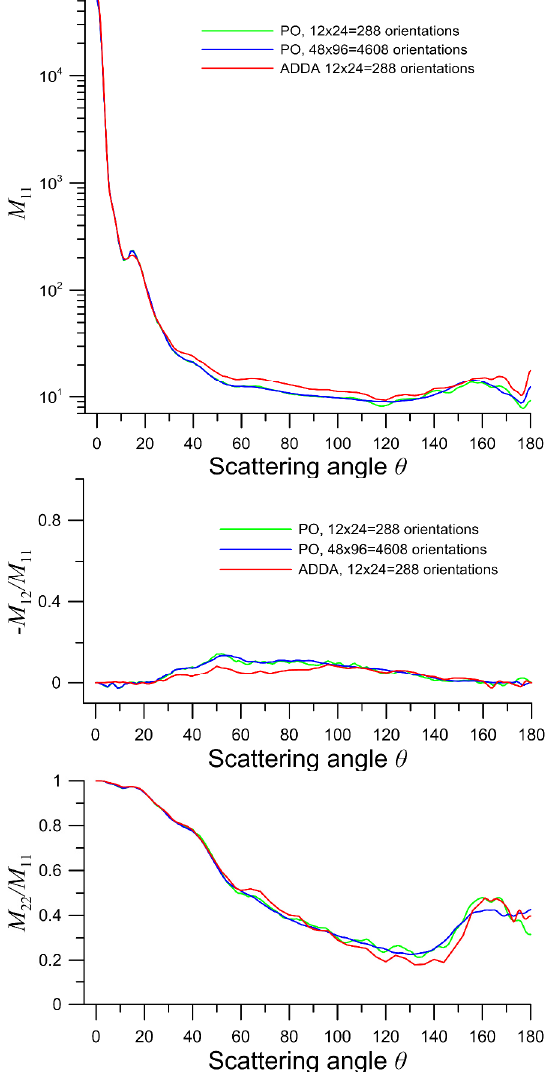
Figure 1. Elements of the Mueller matrix for a randomly oriented dust particle calculated within the physical-optics approximation and discrete dipole approximation for 0.532 μ m.